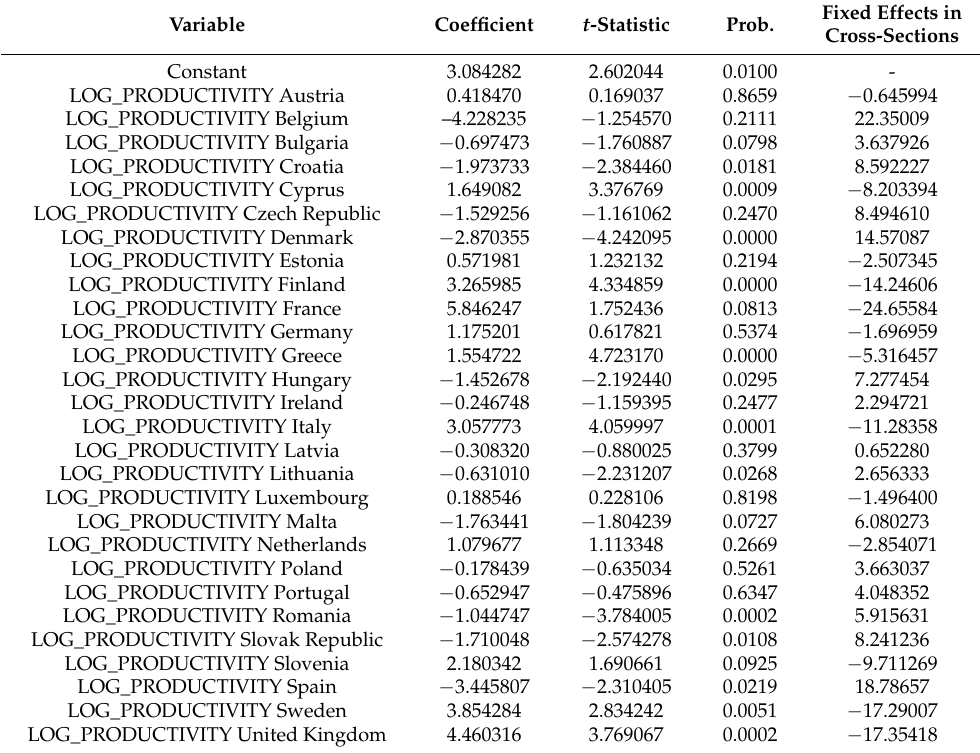
Table 2. Fixed effects model to explain the GHG emissions based on labor productivity in the EU-28 countries